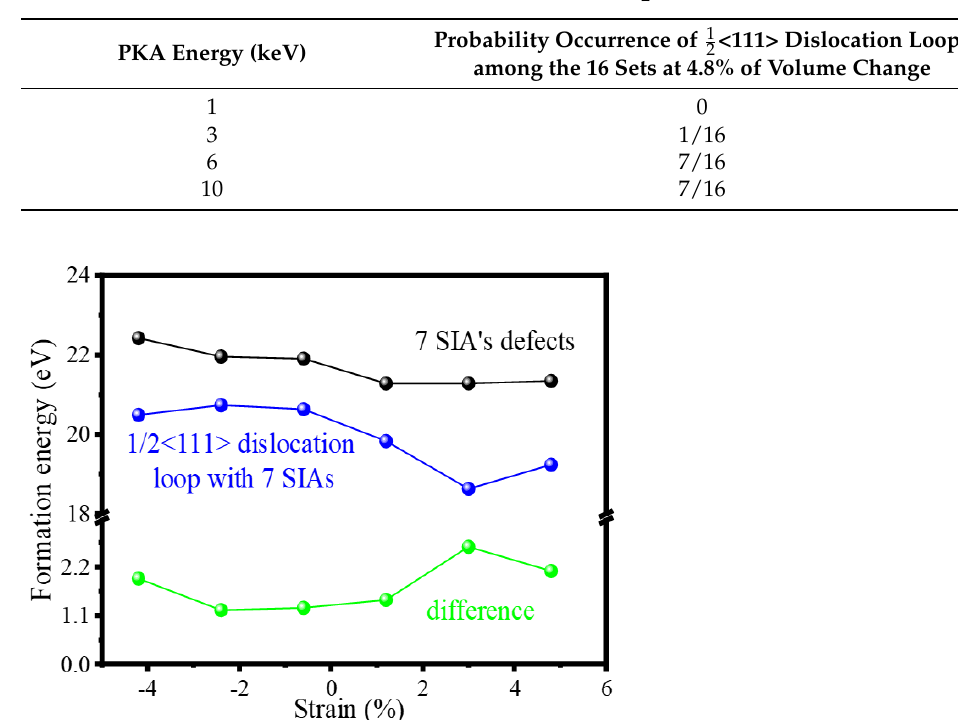
<111> dislocation loop with 7 SIAs 2